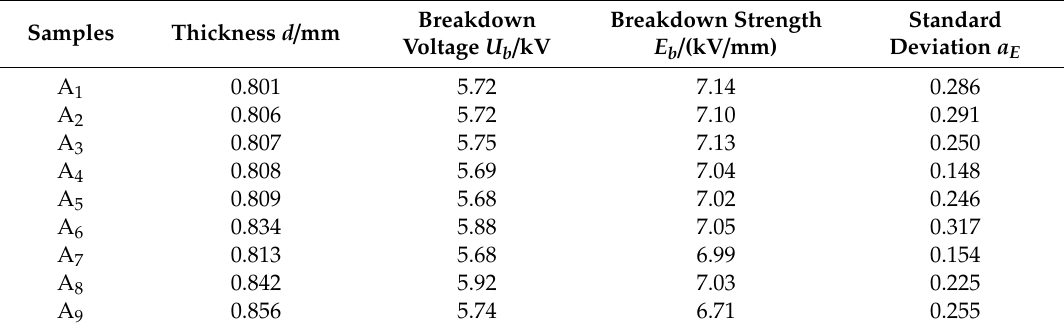
Table 5. Test results of dielectric AC breakdown test of samples from Factory A.